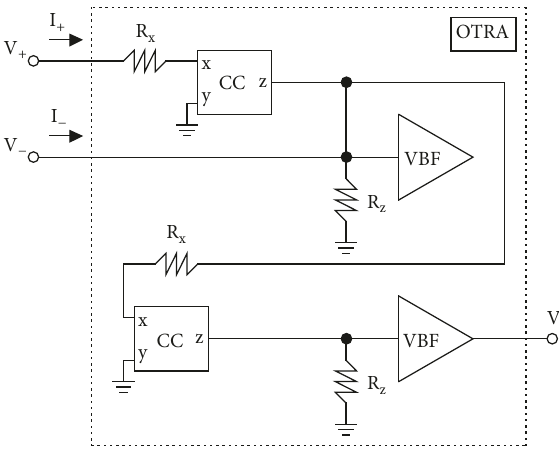
Figure 5: Equivalent circuit model of the OTRA (Figure 2(b)) with parasitic